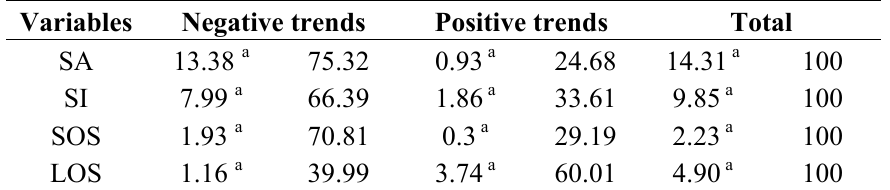
Table 1. The proportions of pixels with statistical trends to total DBF for four variables.